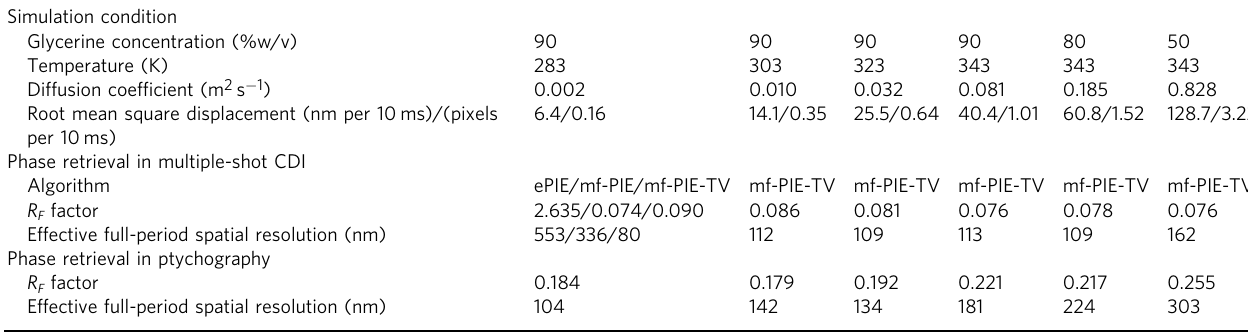
Table 2 Parameters of Brownian motion models and statistics of phase retrieval